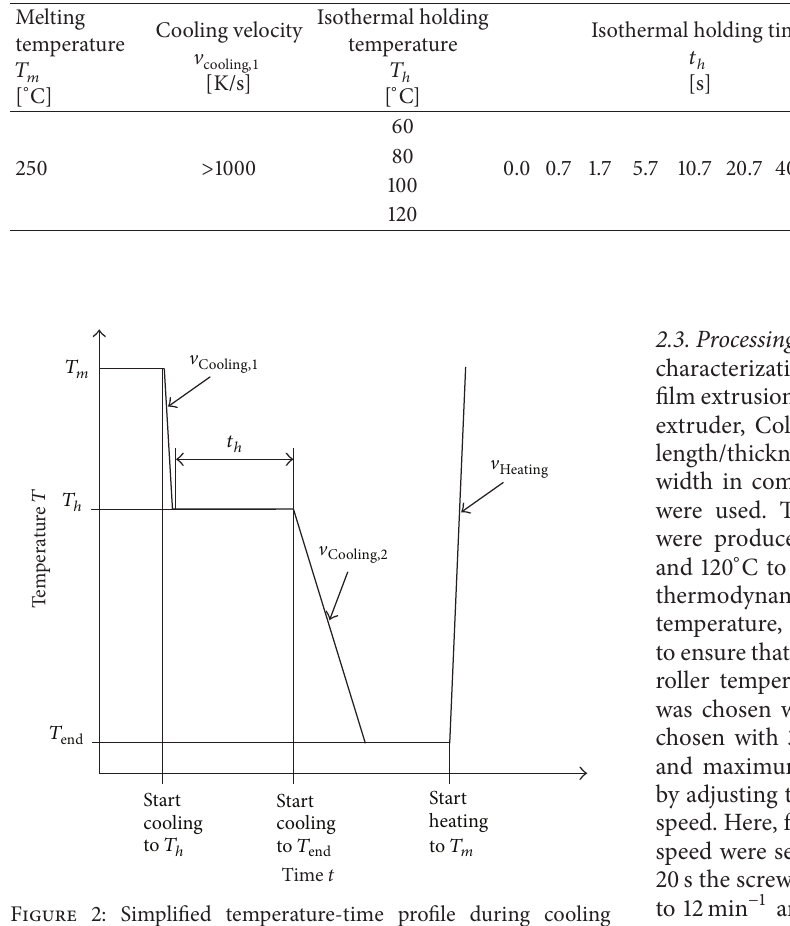
Figure 2: Simplified temperature-time profile during cooling derived from the conventional manufacturing cooling step with subsequent heating analyzed by FSC ( 𝑡 𝐻 = isothermal holding time, 𝑇 = end temperature, 𝑇 ℎ = isothermal holding temperature, 𝑇 𝑚 = end =coolingvelocity,and V =heating meltingtemperature, V Cooling Heating